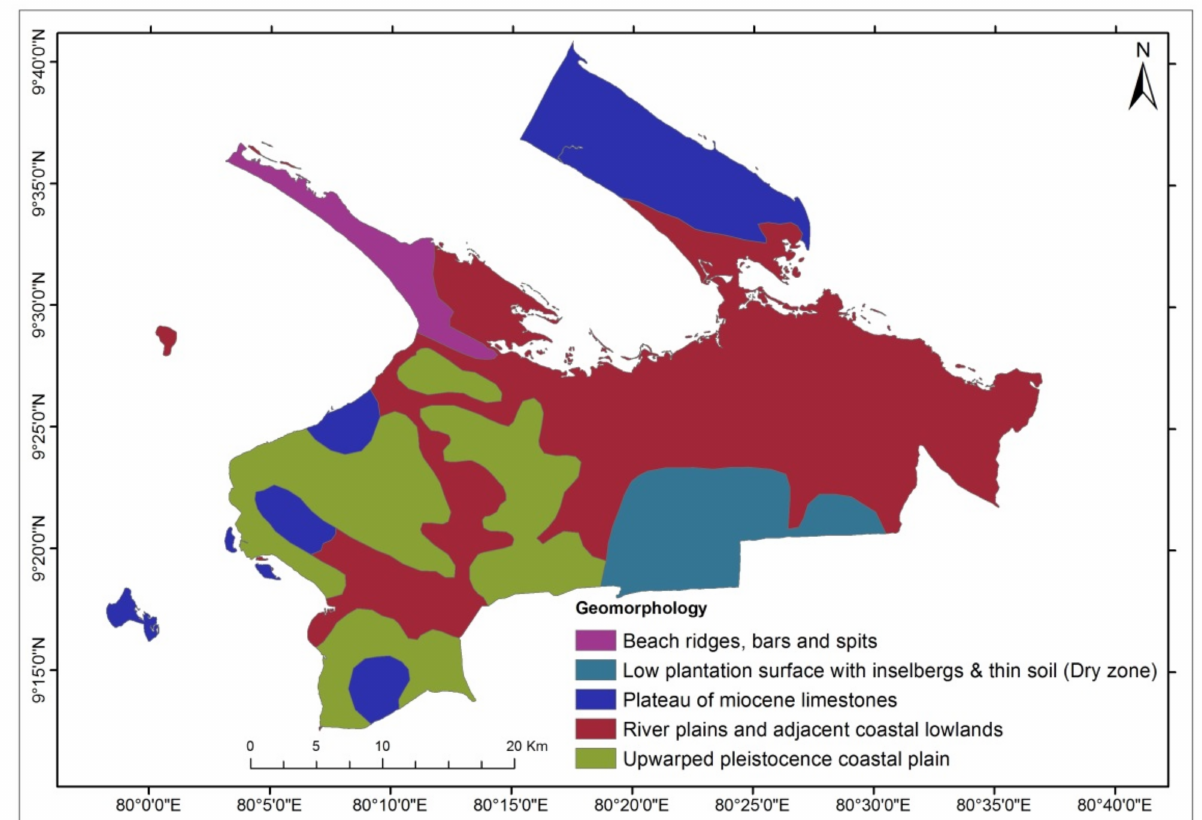
Figure 5. Geomorphology map of Kilinochchi